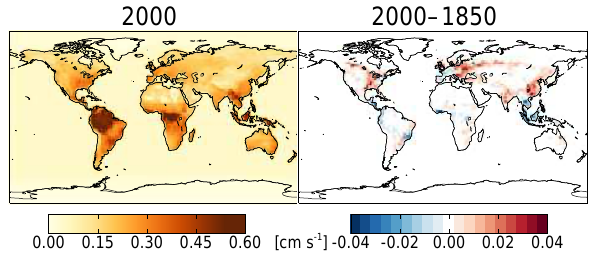
Figure 6. Annual mean simulated dry deposition velocity of ozone for present day (2000) shown on the left; the change due to historical land use change is shown on the